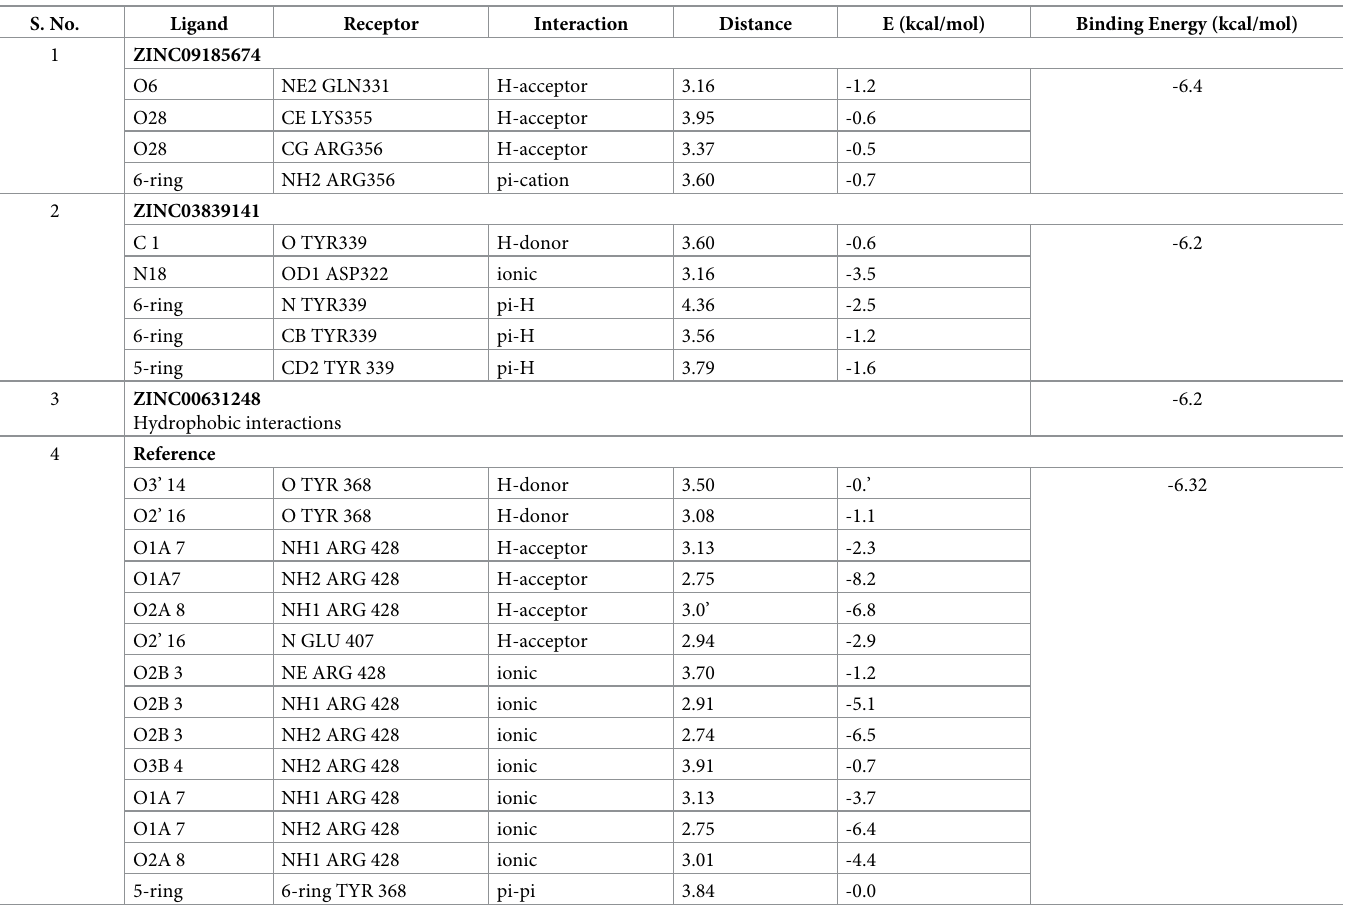
Table 4. Docking scores and identified bond types predicted through MOE tool for shortlisted compounds. S. No.